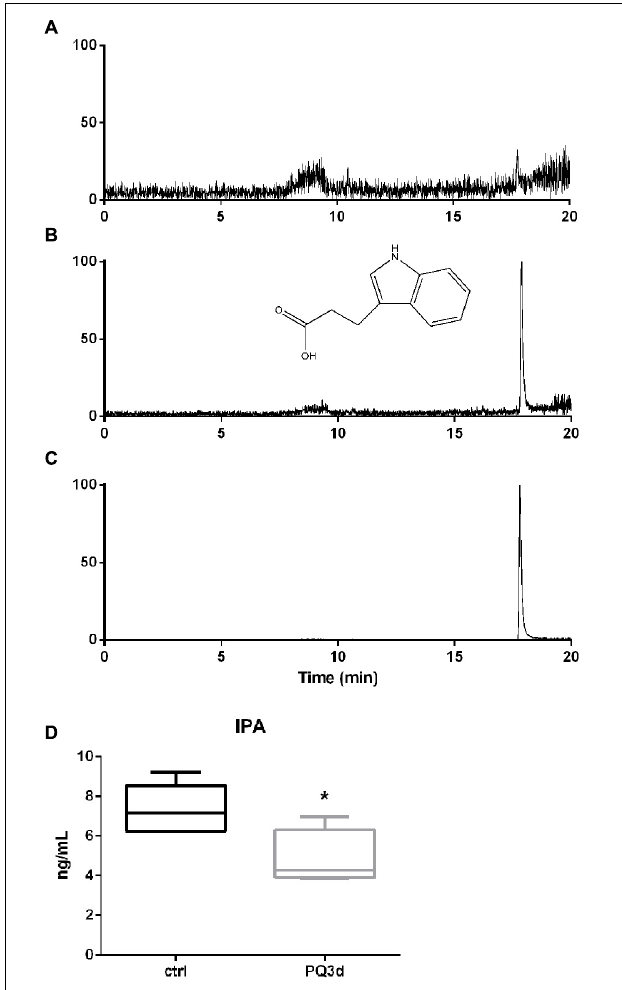
FIGURE 4 | IPA concentrations in mice serum were determined by targeted metabolite profiling. (A) Typical SIM chromatograms of IPA in blank sample. (B) Blank sample spiked with IPA at LLOQ at 1.00 ng/ml. (C) Real serum sample obtained from a mice of the acute group. (D) IPA serum concentrations in Ctrl group and acute PQ intoxication group. * P <